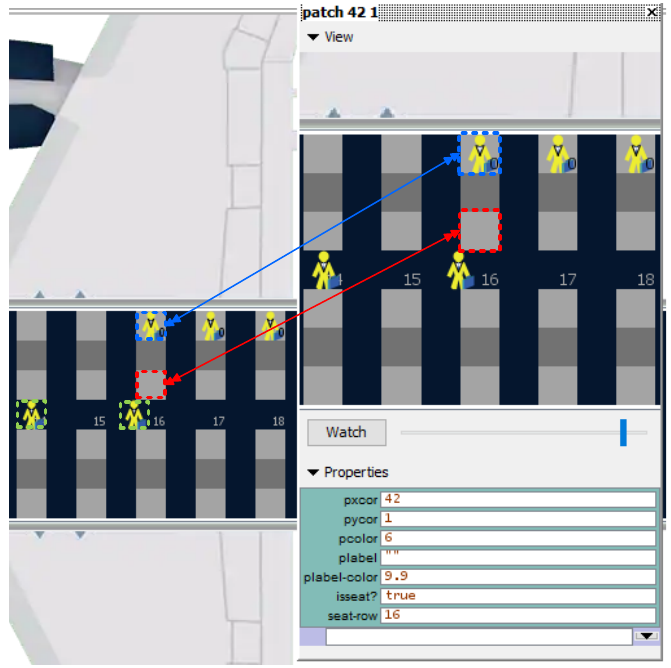
Figure 10. Example of patch agents (marked in dotted red squares) and turtle agents (marked in dotted blue and light green squares).